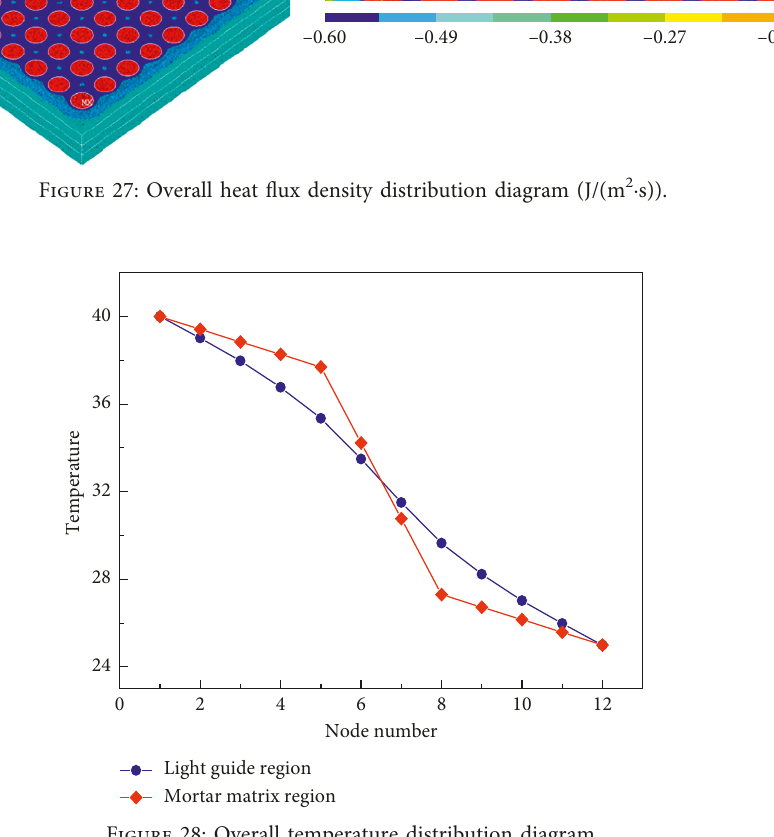
Figure 28: Overall temperature distribution diagram.